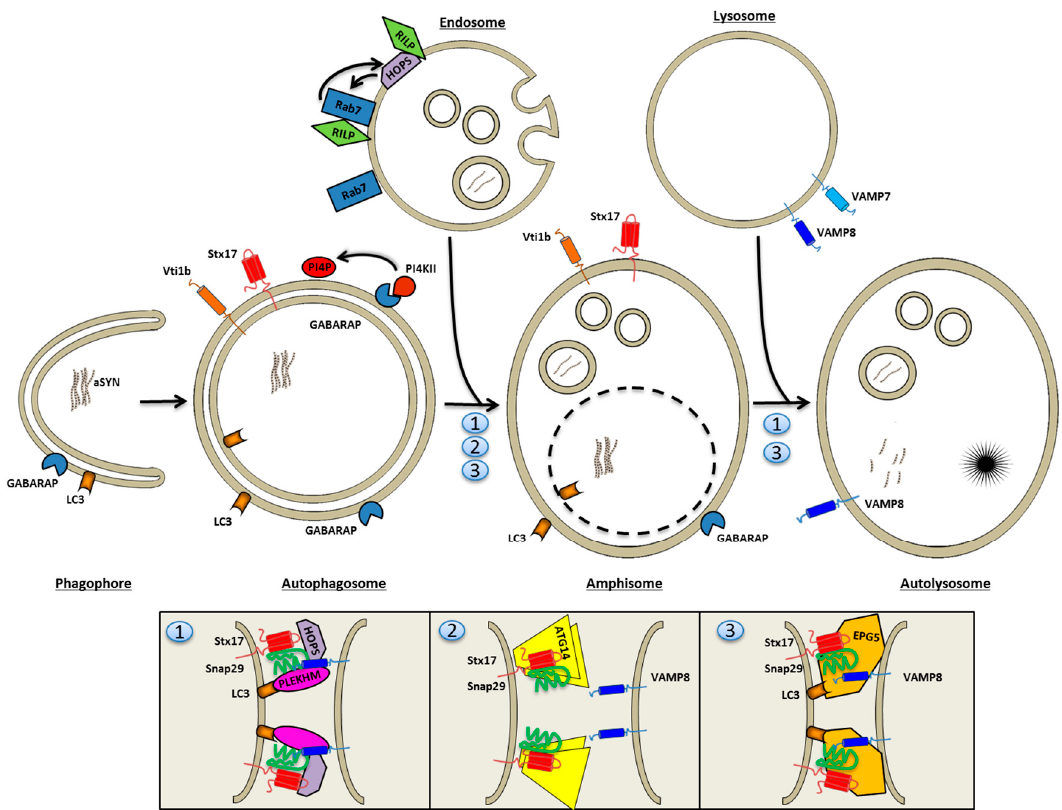
Figure 1. Entry of autophagosomes into the endolysosomal system. The closed autophagosome is contained by two membranes, which allows the ultrastructural distinction of autophagosomes from any other organelle, as the outer membrane is lost upon the first fusion reaction. The autophagosomal Soluble N -ethylmaleimide-sensitive factor-attachment protein receptor (SNARE) syntaxin17 and Atg14, which both influence later fusion reactions, are present on the phagosome Phosphatidylinositol 4-kinase (PI4K)II and its lipid product phosphatidylinositol 4-phosphate (PI4P) is specifically required for autophagososomes and late endosomes to form the hybrid organelle, an amphisome, in a fusion reaction mediated by Homotypic fusion and protein sorting (HOPS) and syntaxin17/Synaptosomal-associated protein (SNAP)29. Atg14 may primarily exert its function also at this stage. The subsequent fusion with lysosomes is also dependent on HOPS and syntaxin17/SNAP29, which partner up to form fusion competent trans-SNARE complexes with lysosomal SNARE Vesicle-associated membrane protein (VAMP)8. Alternative SNAREs for this fusion reaction are potentially v-SNARE Vesicle transport through interaction with t-SNAREs homolog 1B (Vti1b) and t-SNARE VAMP7. A number of factors have recently been identified that promote syntaxin17/SNAP29/VAMP8 interactions in different forms. ATG14 binds syntaxin17 directly, while Microtubule-associated proteins 1A/1B light chain 3B (LC3B) recruits both Pleckstrin homology domain-containing family M (PLEKHM) and Ectopic P-Granules Autophagy Protein 5 Homolog (EPG5) to the autophagosome. Here EPG5 (3) stabilizes the trans-SNARE complex with VAMP8, while PLEKHM (1) and ATG14 (2) interact with the bivalent SNARE pair syntaxin17/SNAP29.